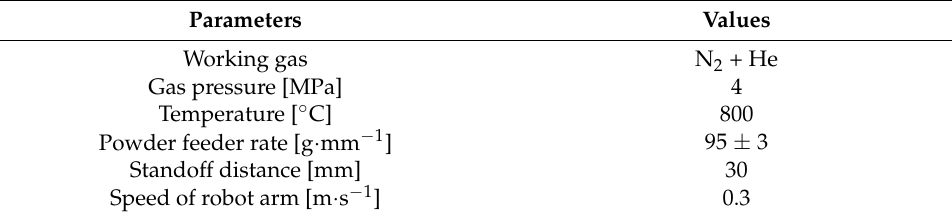
Table 2. Parameters of the cold-spray